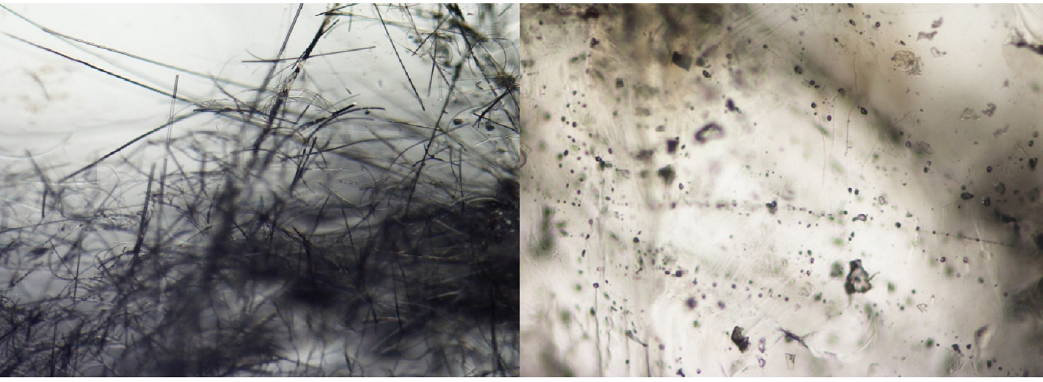
Figure 5: Study of